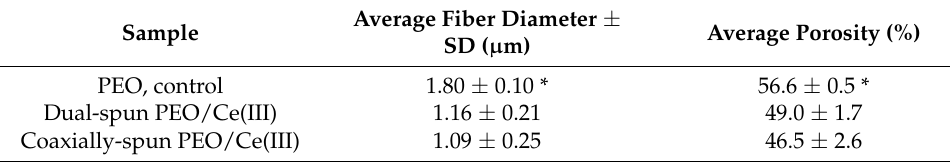
Table 2. Fiber diameter and membrane porosity of electrospun scaffolds.